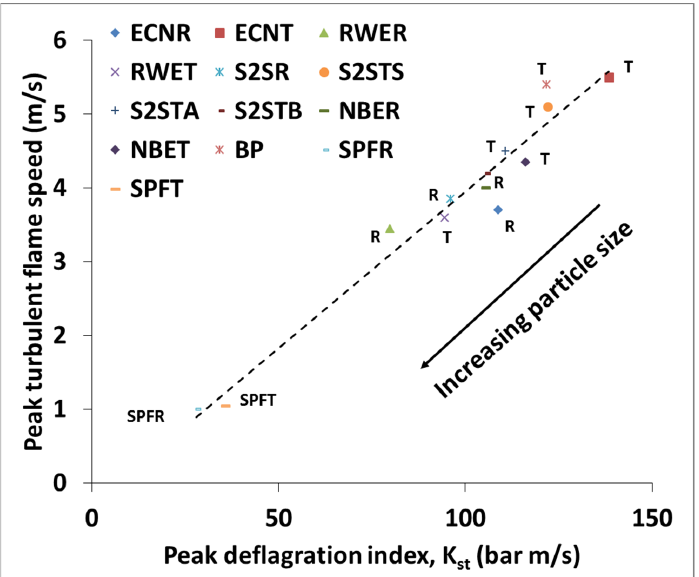
Figure 10. Correlation of peak turbulent flame speed (ST, max) with peak deflagration index (Kst) for present samples in comparison to other results of raw (R) and thermally treated samples (T) [30,39,42,58,59].